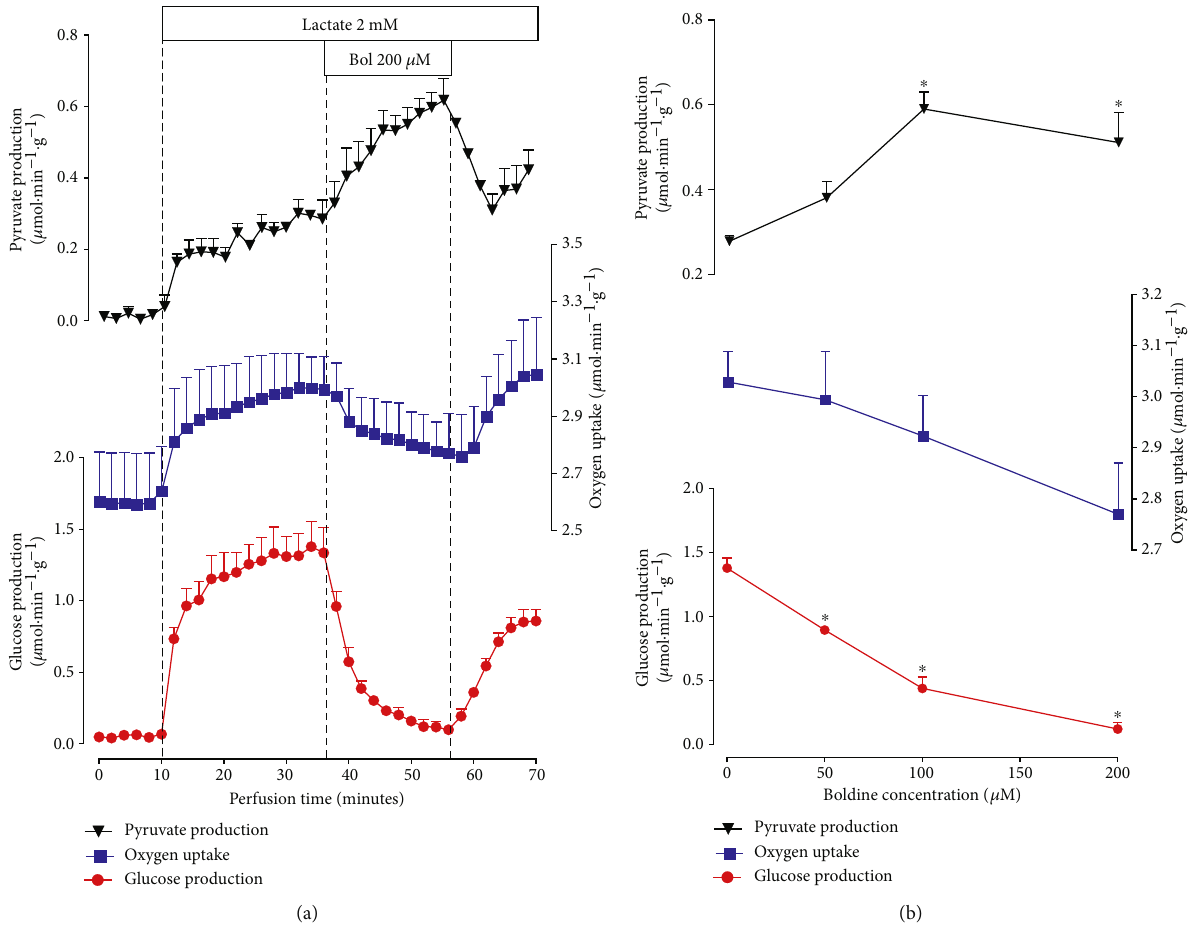
Figure 2: E ff ect of boldine on the lactate gluconeogenesis in the perfused liver isolated from fasted rats. Time courses (a) and concentration- dependent e ff ects of boldine (b) on lactate gluconeogenesis and related parameters in the livers isolated from fasted rats. Liver was perfused as described in the Materials and Methods. In (a), data are the means ± mean standard errors of 3 to 4 liver perfusion experiments. Boxes near the time scale indicate the lactate and boldine infusion periods and concentrations. In (b), the rates of pyruvate and glucose productions and oxygen uptake were evaluated at 36 minutes of perfusion time (control condition, zero boldine concentration; n = 10 ) and at 56min perfusion time (20 minutes after starting boldine infusion; n = 4 ). Asterisks ( ∗ ) in (b) indicate those rates that di ff er from the control condition (absence of boldine; p ≤ 0 : 05